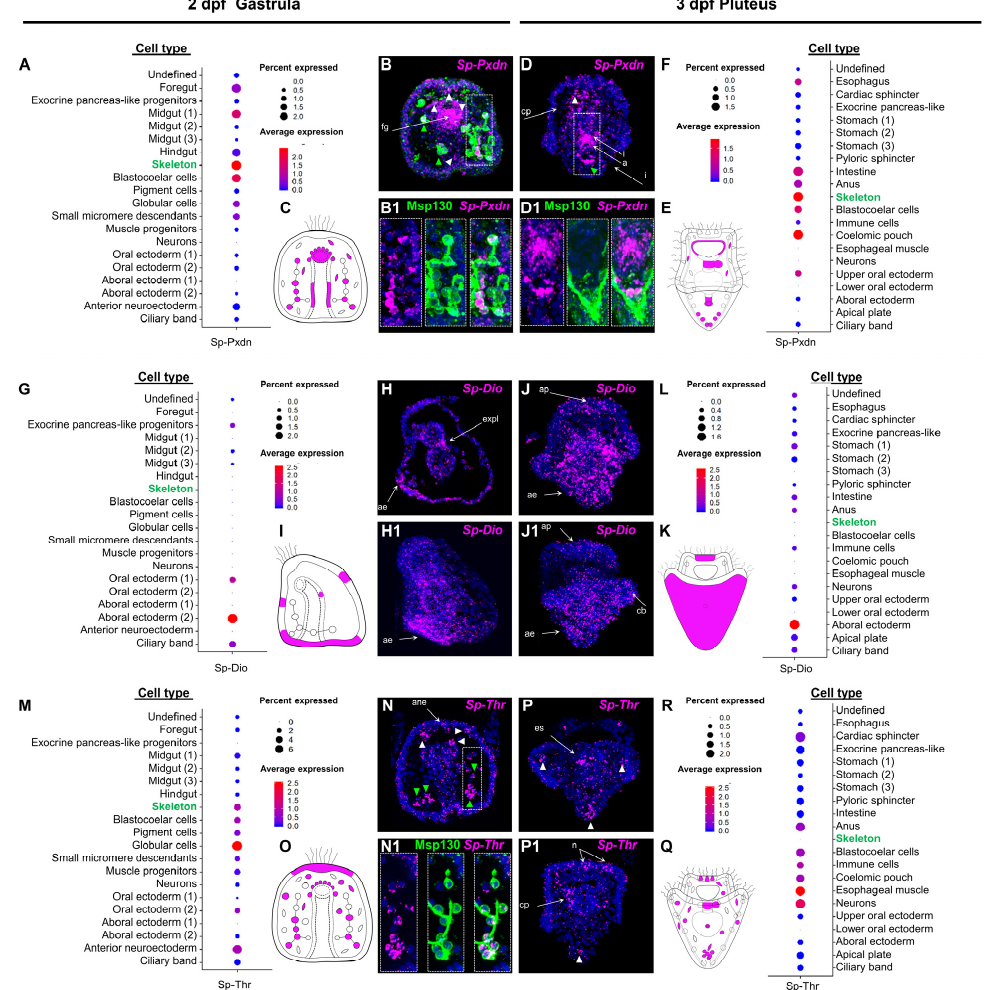
Figure 1. Spatiotemporal expression pattern of putative sea urchin TH pathway components. ( A , F , G , L , M , R ) Dotplot showing the average expression and percentage of cells per cluster con- taining transcripts for Sp-Pxdn at 2 dpf, Sp-Pxdn at 3 dpf, Sp-DIO at 2 hpf, Sp-DIO at 3 dpf, and Sp-Thr at 2 dpf, Sp-Thr at 3 dpf, respectively. ( B , B1 , D , D1 ) Coupled FISH-IHC showing the expression of Sp-Pxdn in PMC, as indicated by the colocalization of Sp-Pxdn transcripts and the immunoreactivity- based signal of the skeletal marker Msp130 at 2 and 3 dpf. White triangles= blastocoelar cells. Green triangles= skeletogenic cells. ( H,H1 , J,J1) FISH showing the expression pattern of Sp-DIO at 2 and 3 dpf. ( N , N1 , P , P1 ) coupled FISH-IHC showing the expression patterns of Sp-Thr and Msp130 at 2 and 3 dpf. White triangle= blastocoelar cells. ( C , E , I , K , O , Q ) Schematic representations of the expression domains of Sp-Pxdn at 2 ( C ) and 3 ( E ) dpf, Sp-Dio at 2 ( I ) and 3 ( K ) dpf, and Sp-Thr at 2 ( O ) and 3 ( Q ) dpf as illustrated by the dotplots. a= anus; ae= aboral ectoderm; ane = anterior neuroectoderm; ap= apical plate; cp = coelomic pouch; es = esophagus; expl = exocrine pancreas-like; fg = forefut; I = intestine; n = neurons.